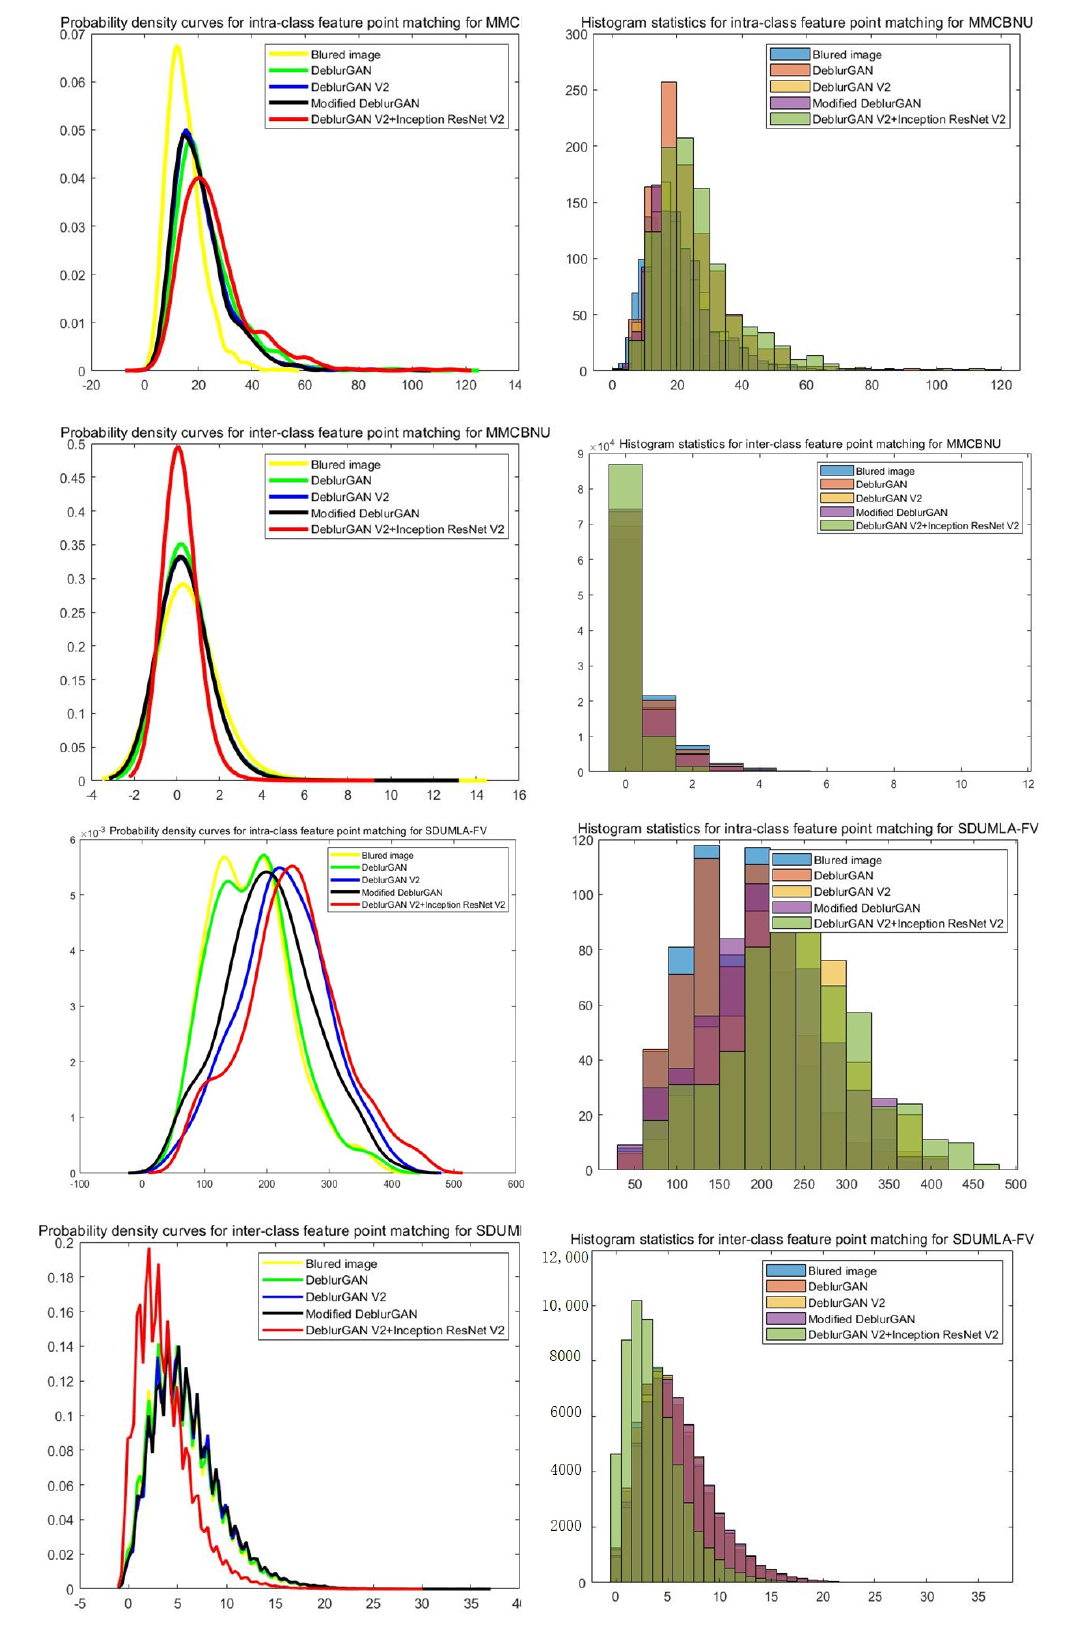
Figure 8. The intra-class and inter-class probability density distribution plots and fea- ture point histogram statistical plots of various deblurring methods on the MMCBNU and SDUMLA-FV